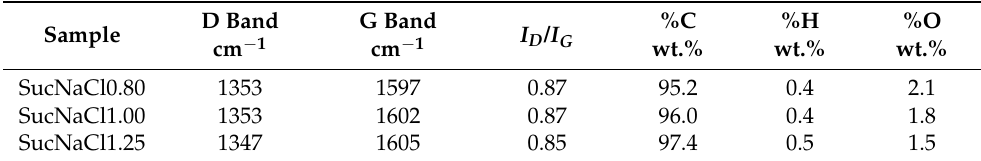
Table 2. Carbon nanotexture (from Raman spectroscopy), and weight % of C, H and O (from elemental